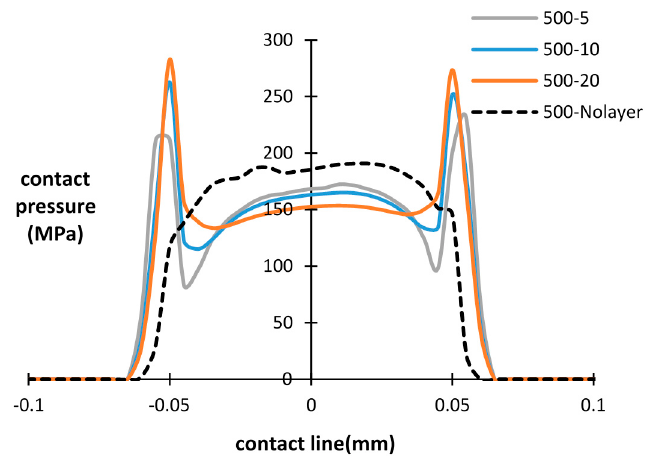
Figure 8. Contact pressure distribution for different layer thicknesses and number of cycles: layer thickness = 5 µm, 10 µm, 20 µm and without layer after 500 cycles.